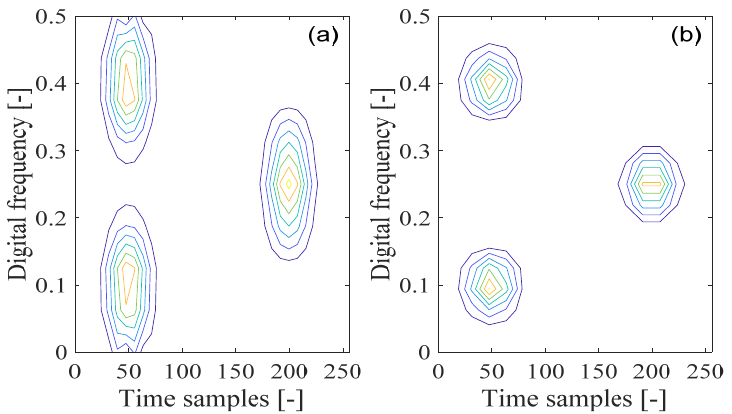
Figure 3. The spectrogram of a nonstationary signal composed of three transient Gaussian components by adopting the Hamming type of window function; ( a ) 15 samples window length; ( b ) 31 samples window length.